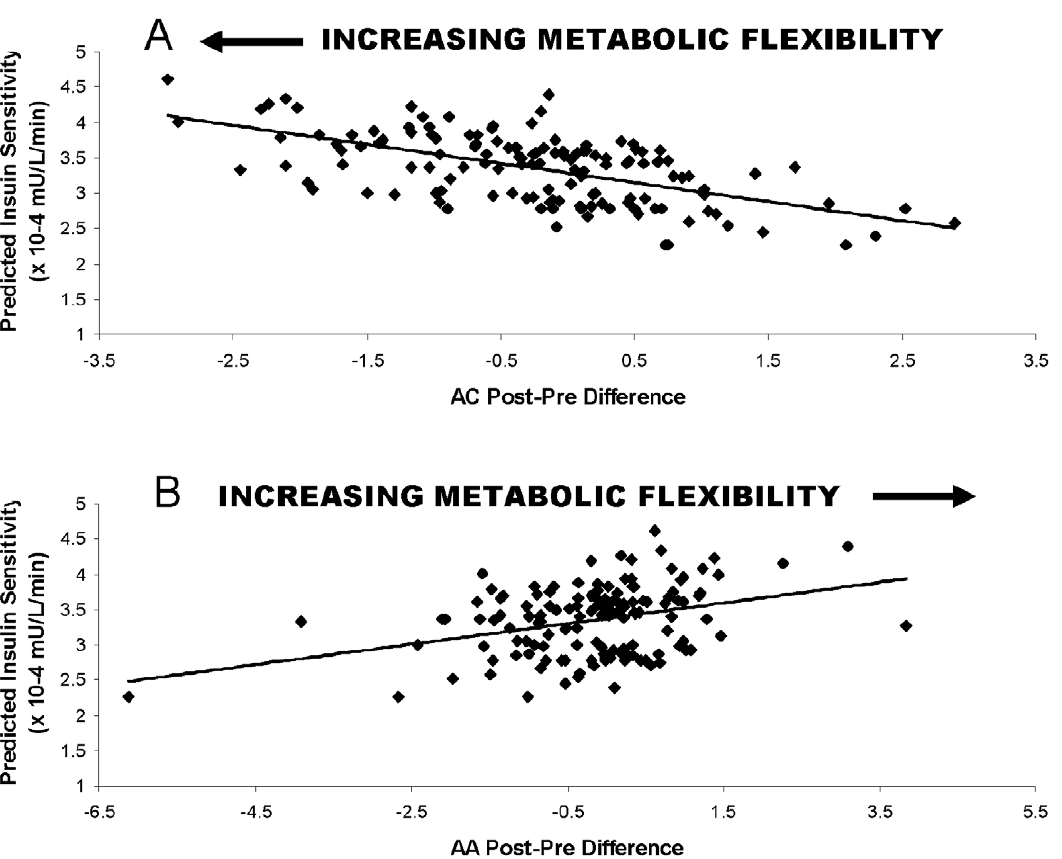
Figure 4. Correlation Between Fasting to Postprandial Component Changes and Predicted S I Change Over Time. As described in Methods, fasting and postprandial concentrations of amino acids and acylcarnitines were measured at baseline, three months, and six months, and fasting to postprandial components were generated. S I was determined from insulin and glucose concentrations measured during a frequently sampled intravenous tolerance test at each of baseline, three, and six months. Linear models were used to relate time varying concentrations of fasting to postprandial amino acid and acylcarnitine component to time varying insulin sensitivity (S I ). Scatter plots depict the relation between fasting to postprandial component scores and predicted S I . A. Relation between Acylcarnitines (AC) Fasting to Postprandial Component Scores and Predicted S I Over Time. Since postprandial AC concentrations are larger than fasting, more negative fasting to postprandial differences represent more metabolic flexibility. B. Relation between Amino Acid (AA) Fasting to Postprandial Component Scores and Predicted S I Over Time.